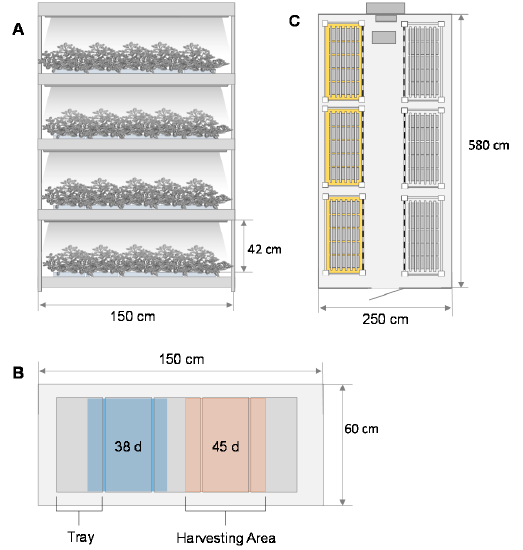
Figure 1. Simplified scheme of the experimental setup showing the ( A ) structure of a shelf with four levels and the ( B ) top view of one exemplary shelf with the respective arrangement of the five trays and the two harvesting areas, as characterized by two different colored areas and exemplary marked with one tray and one harvesting area. ( C ) shows an overview of the indoor farm used and the yellow marked position of the shelves used for the experimental setup.